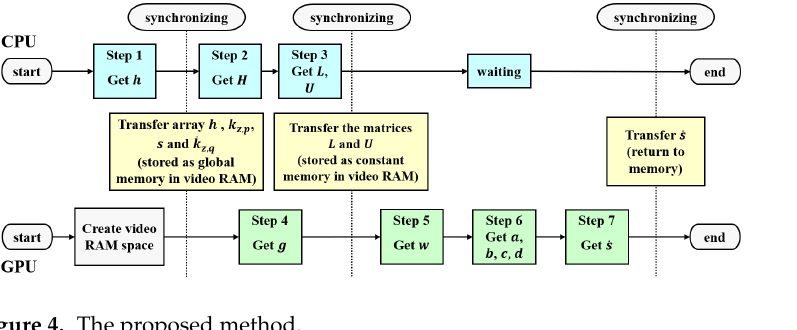
Figure 4. The proposed method.